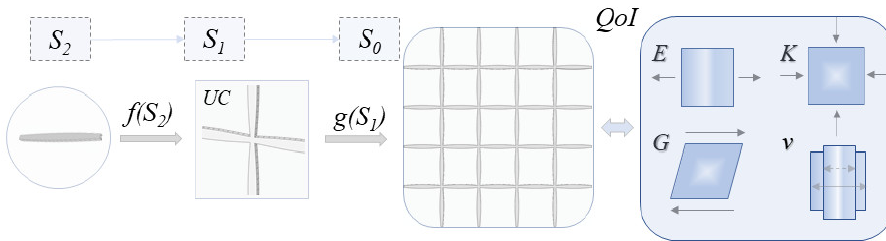
Figure 1. A multiscale metamaterial design, with the effective material properties (S 0 ) to be deter- mined by the first-scale unit-cell (UC, S 1 ) and inner-element scale design (S 2 ) of the periodic pattern. The effective metamaterial normal E, bulk K, shear G and Poisson’s ratio ν attributes are a function of the S 2 and S 1 scale design.